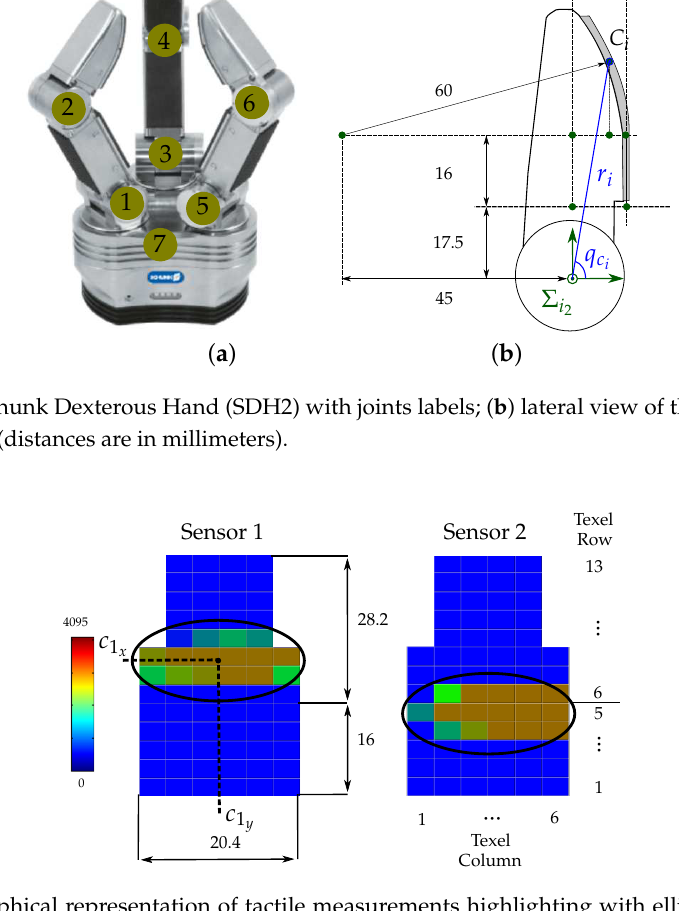
Figure 10. Graphical representation of tactile measurements highlighting with ellipses the contact region on each sensor pad. The bar in the left indicates the scale of colors corresponding to the force values returned by each texel, the range of returned values from 0 to 4095 corresponds to a range of forces from 0 to 3 N. The five lower rows of texels correspond to the planar part of the sensor. All the lengths are in millimeters. (see also Figure